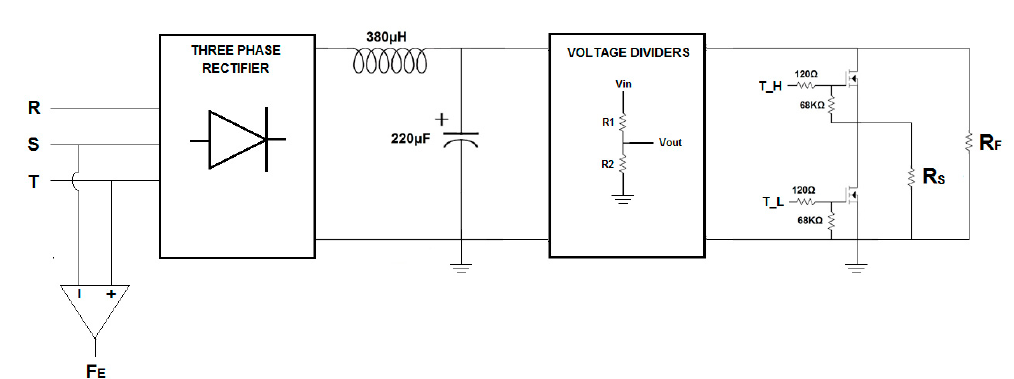
Figure 3. The power electronics stage is composed of: a three-phase rectifier to obtain the DC voltage provided by the PMG connected to the microturbine; an LC Filter to eliminate the possible voltage ripple; three voltage dividers; and one leg of MOSFET transistors switching at high